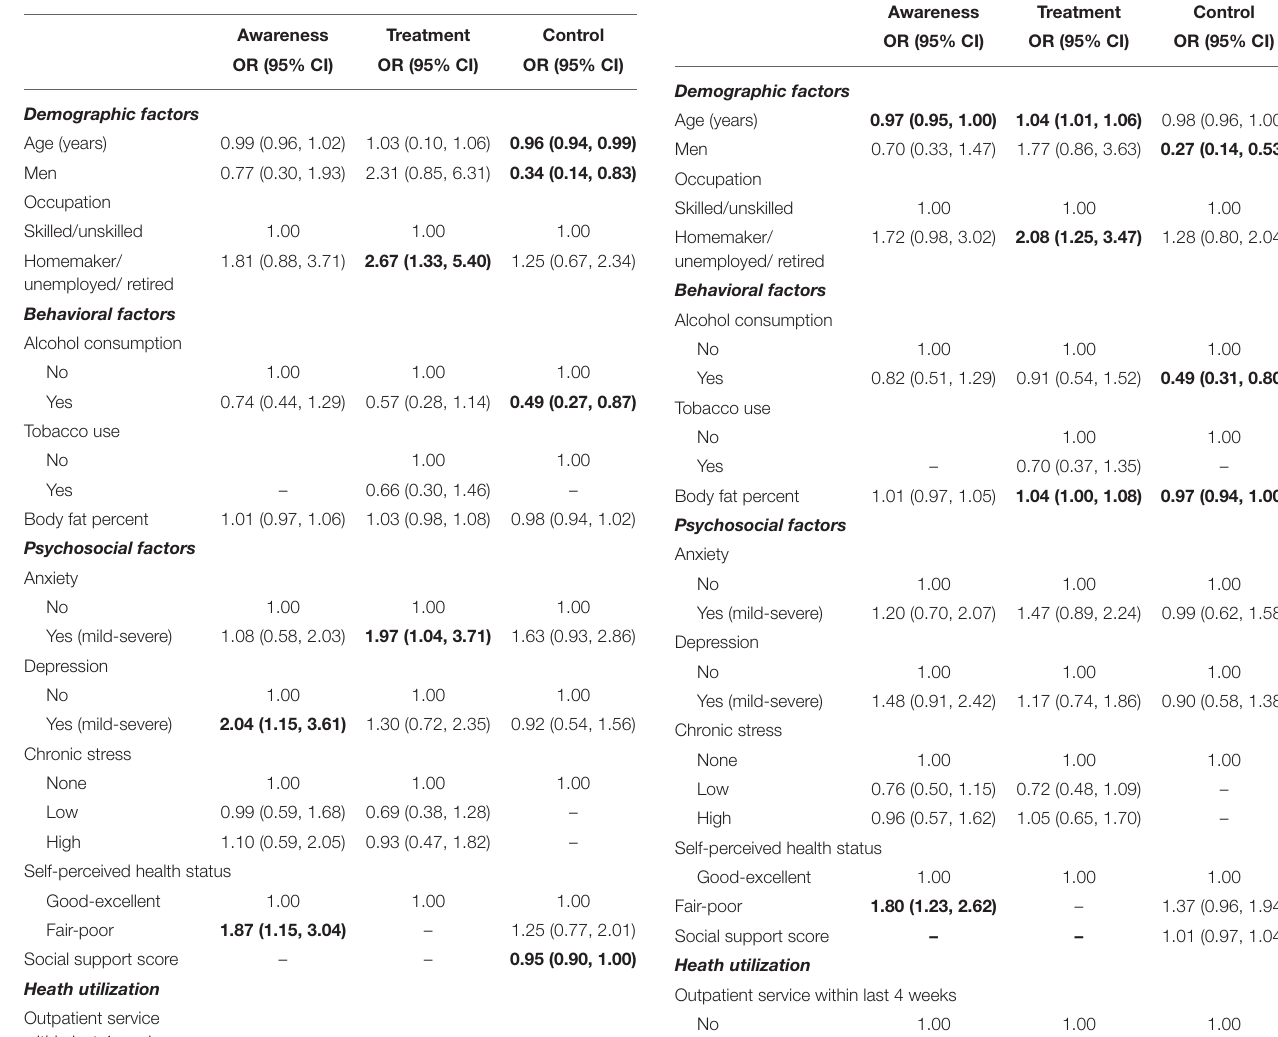
TABLE 4 | Factors associated with hypertension awareness, treatment, and control at baseline (cross-sectional analysis among hypertensive participants, n = 467) a .